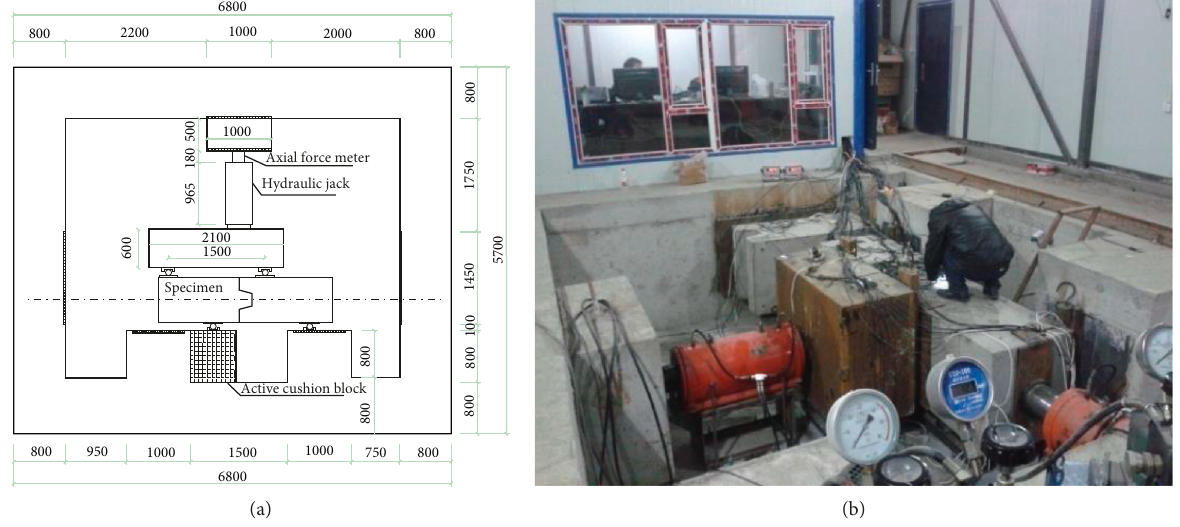
Figure 6: Layout of the experimental loading